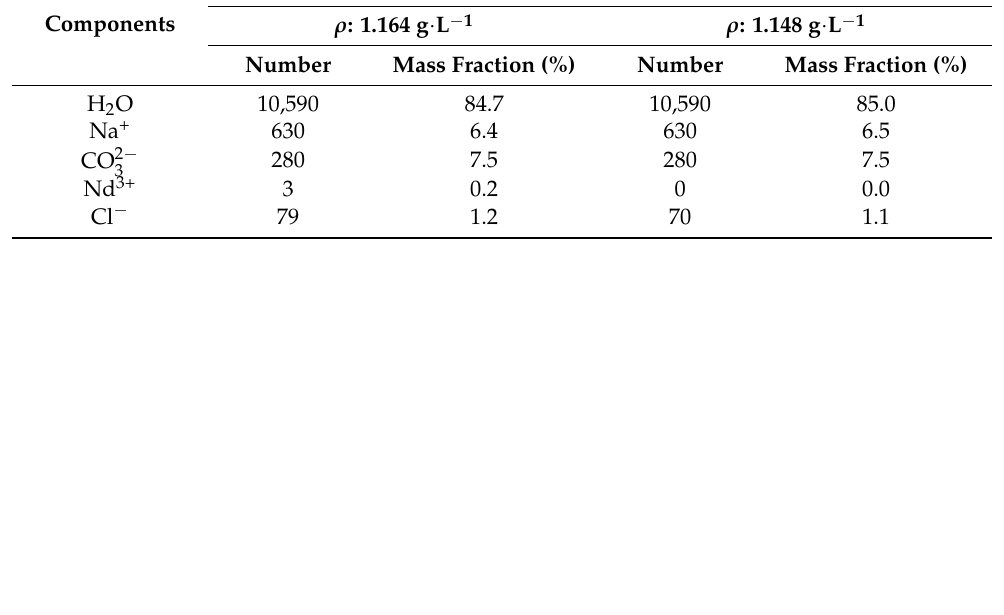
Table 3. Modeling parameters of the solutions.